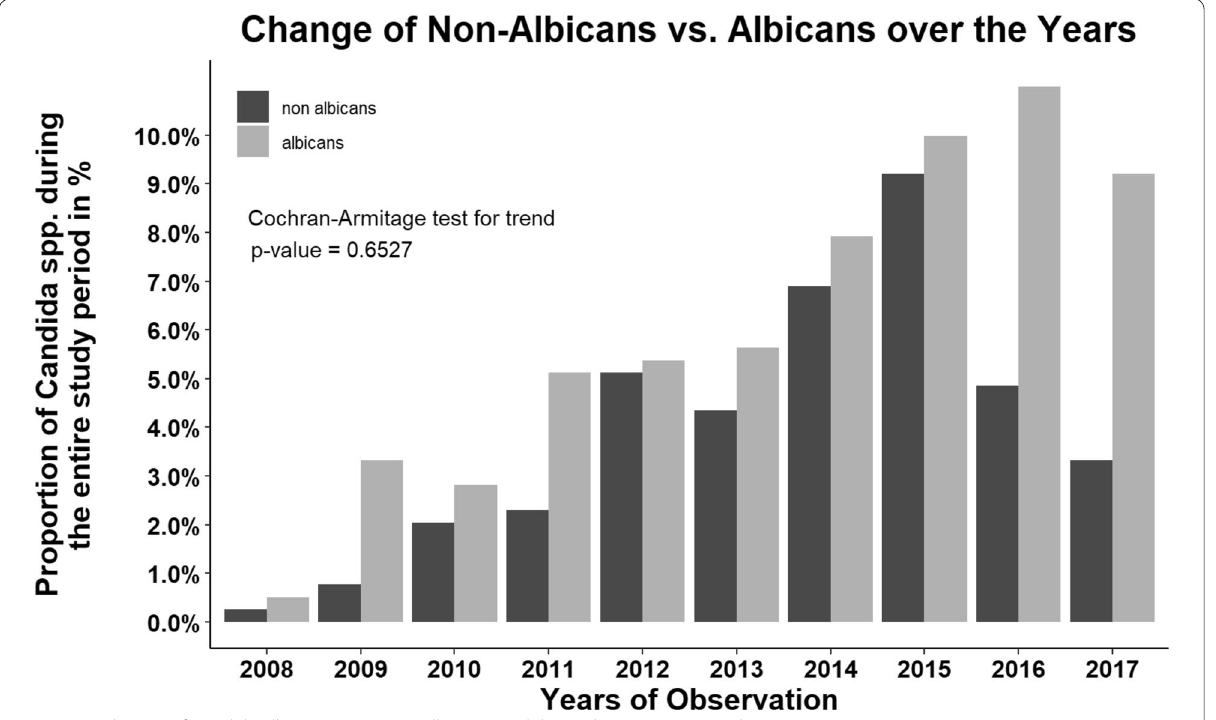
Fig. 2 Distribution of Candida albicans versus non‑ albicans Candida spp. between 2008 and